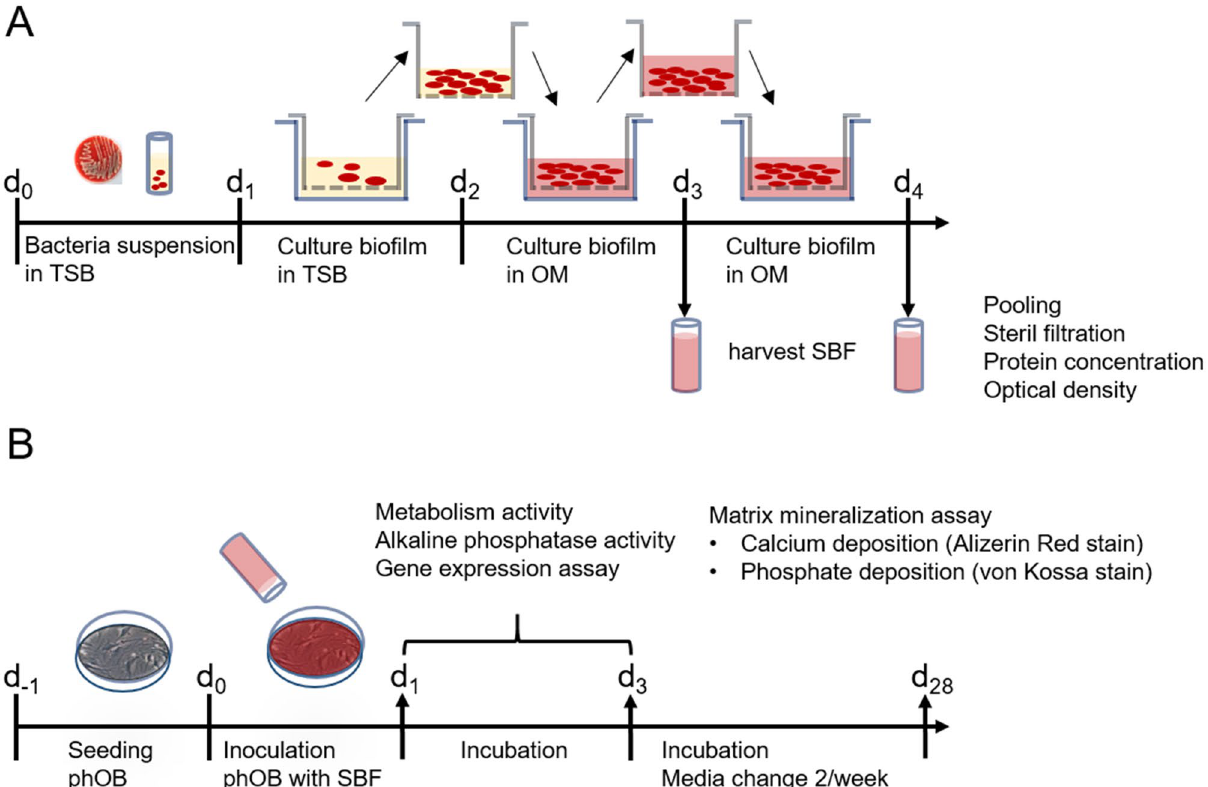
Figure 8. Preparation of soluble biofilm factors (SBF). Illustration of the single steps along the timeline. TSB tryptic soy broth, OM osteogenic medium ( A ). Experimental design. Illustration of the experimental steps and endpoints along the timeline. phOB primary human osteoblasts ( B